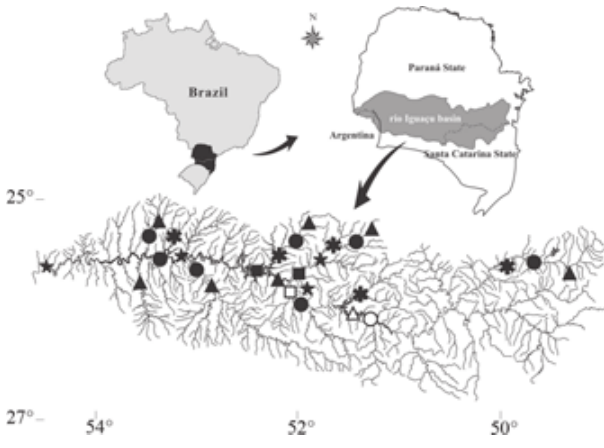
Fig. 8. Geographic distribution of the five species of Hypostomus in the rio Iguaçu basin. Hypostomus albopunctatus (star), H. commersoni (asterisk), H. derbyi (triangle), H. myersi (dot) and H. nigropunctatus (square). Open symbols are the type